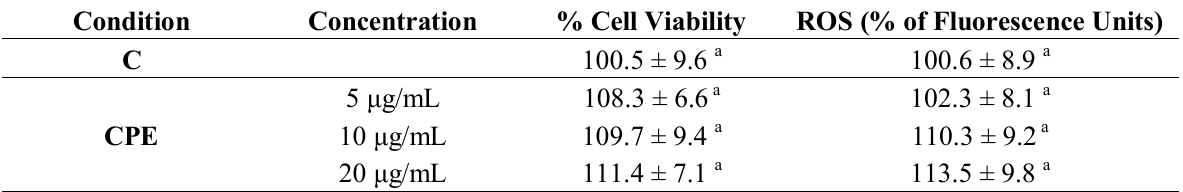
Table 1. Effect of 20 h treatment with noted concentrations of CPE on cell viability and intracellular ROS generation in pancreatic Ins-1E cells.